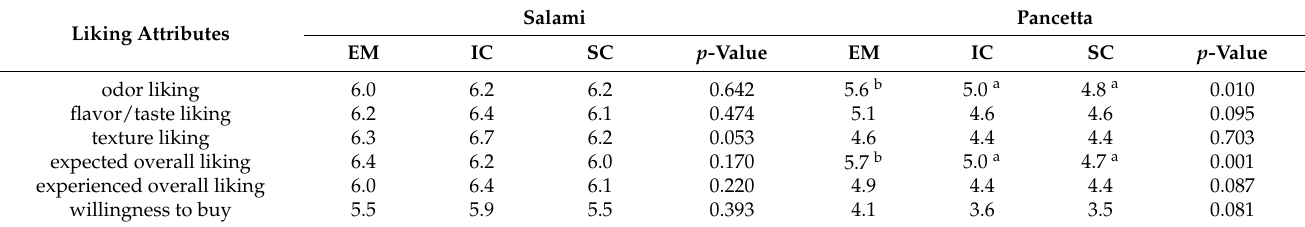
Table 4. Mean liking scores and willingness to buy salami and pancetta product samples ( n =